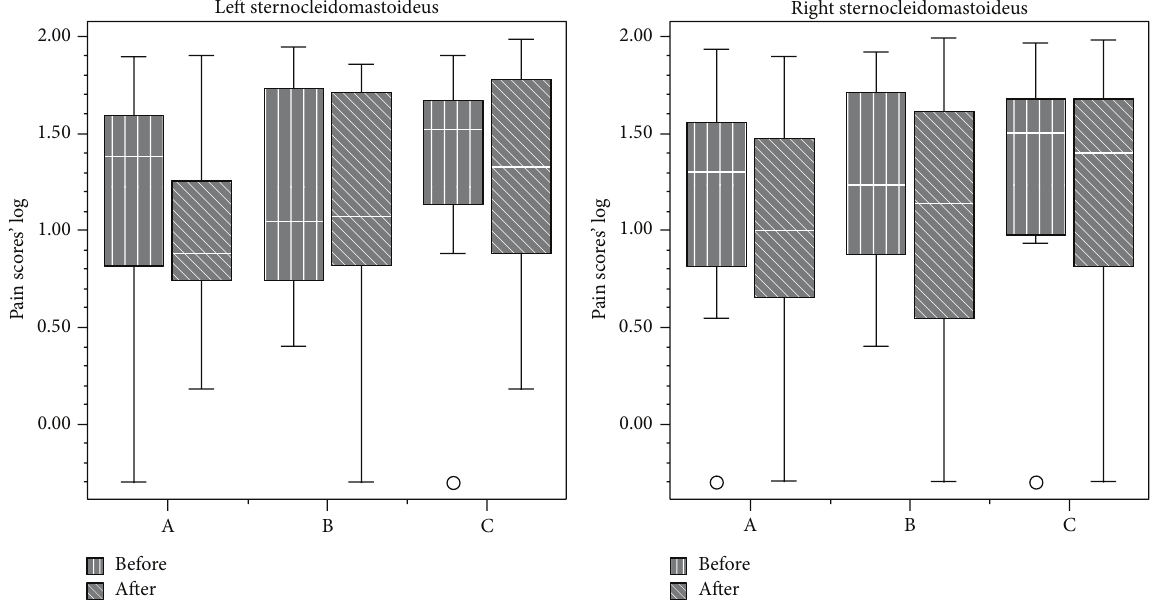
Left sternocleidomastoideus Right sternocleidomastoideus